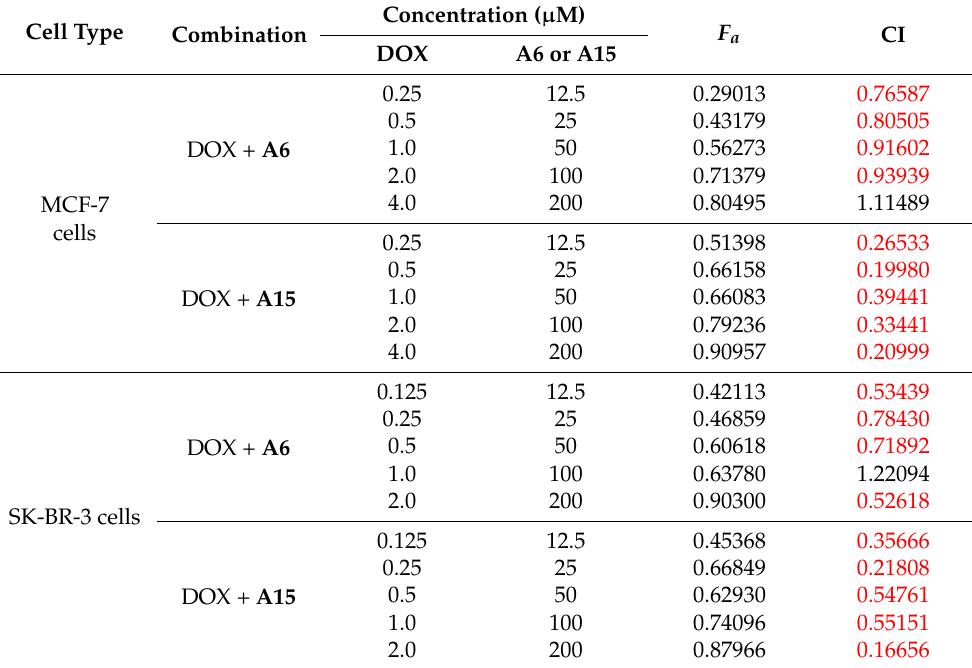
Table 1. Fractional effects ( F a ) and combination index (CI) values of the combination treatment of doxorubicin (DOX) with A6 or A15 at fixed ratios on MCF-7 and SK-BR-3 cells. Cell